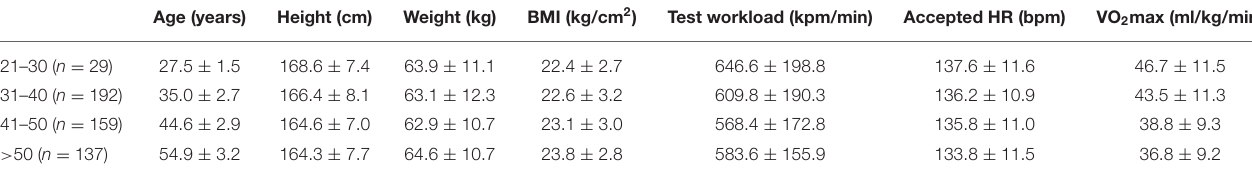
TABLE 1 | The anthropometric and cardiopulmonary aerobic test information in different age groups (data was shown in mean ± SD). Age (years) Height (cm) Weight (kg) BMI (kg/cm 2 ) Test workload (kpm/min)